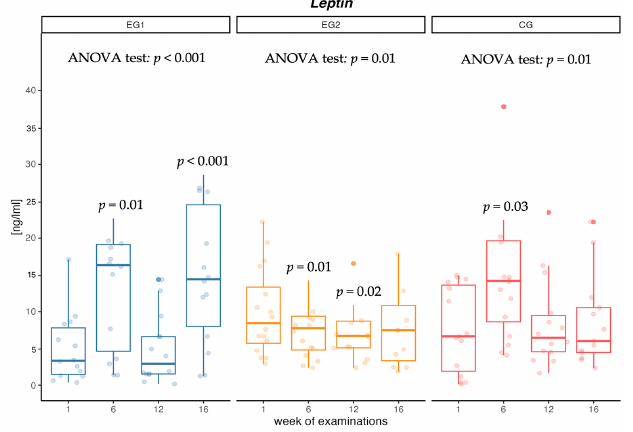
Figure 2. Changes in leptin (LEP) concentration [ng/ml] in aerobic group (EG1), aerobic-resistance group (EG2) and control group (CG) during weeks of examinations. No changes in OMEN concentration were observed both between groups and be- tween measurements. Despite the lack of statistically significant changes, it was shown